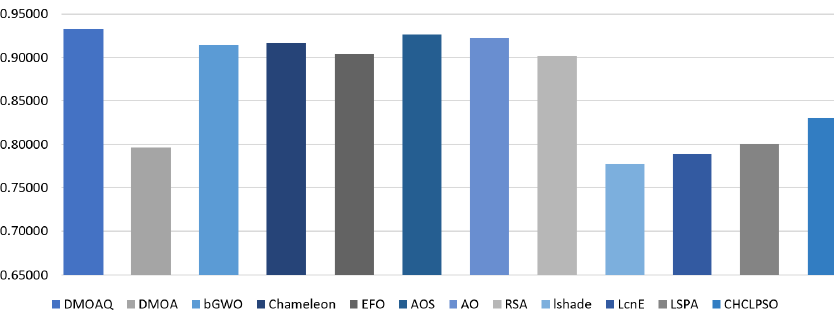
Figure 6. Average of the classification accuracy for UCI